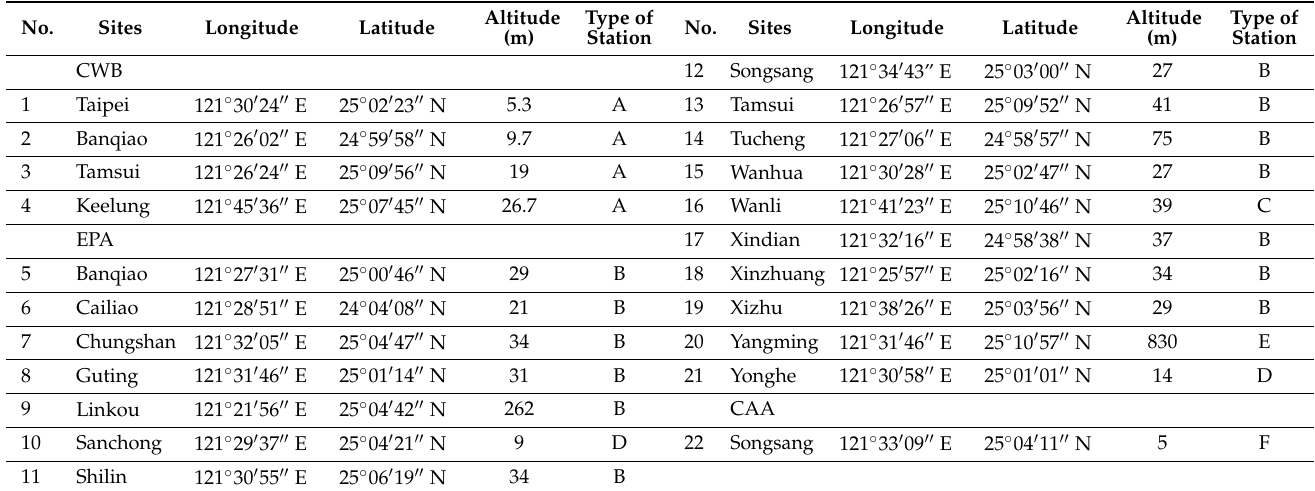
Table 1. Geographical information for the four meteorological sites, one airport site, and 17 air-quality monitoring